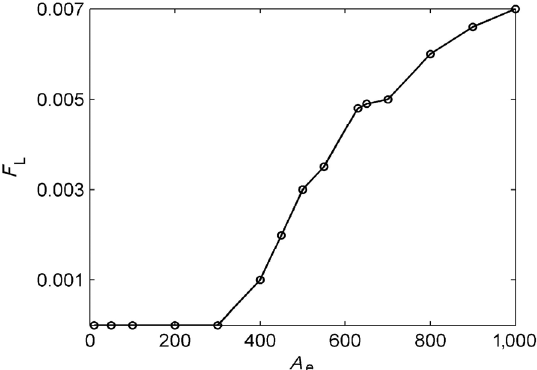
Fig. 5 Dependence of average friction force on attraction intensity.